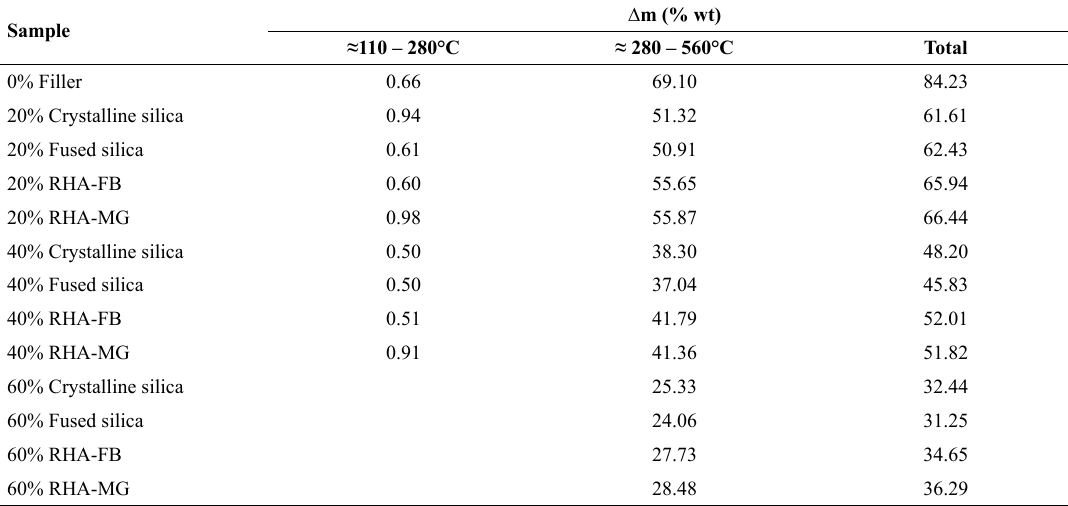
Table 3. Critical limits of the thermogravimetric analysis of